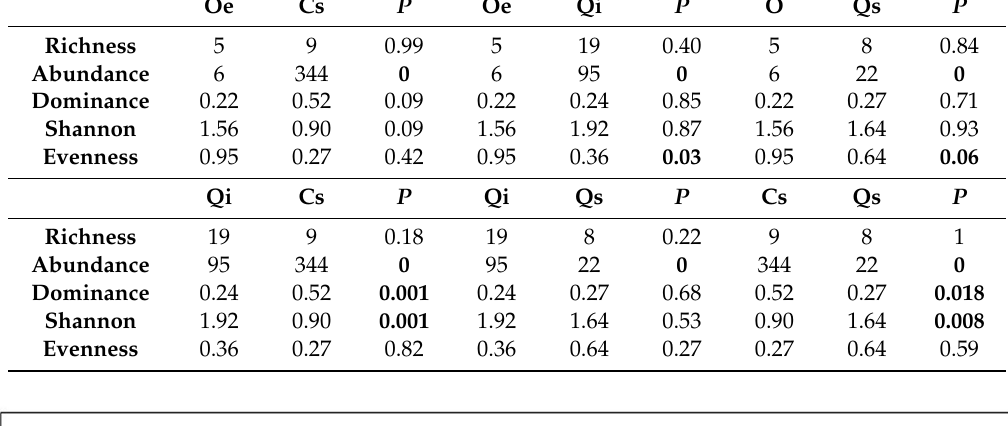
Table 5. Richness (species number), abundance (specimen number), dominance (Simpson’s index), diversity (Shannon–Wiener H’), evenness indices for saproxylic communities linked to each tree species (Cs: C. siliqua ; Oe: O. europaea ; Qi: Q. ilex ; Qs: Q. suber ), and paired comparisons between them. p = bootstrapping comparisons. Values with statistical significance are highlighted in bold type.